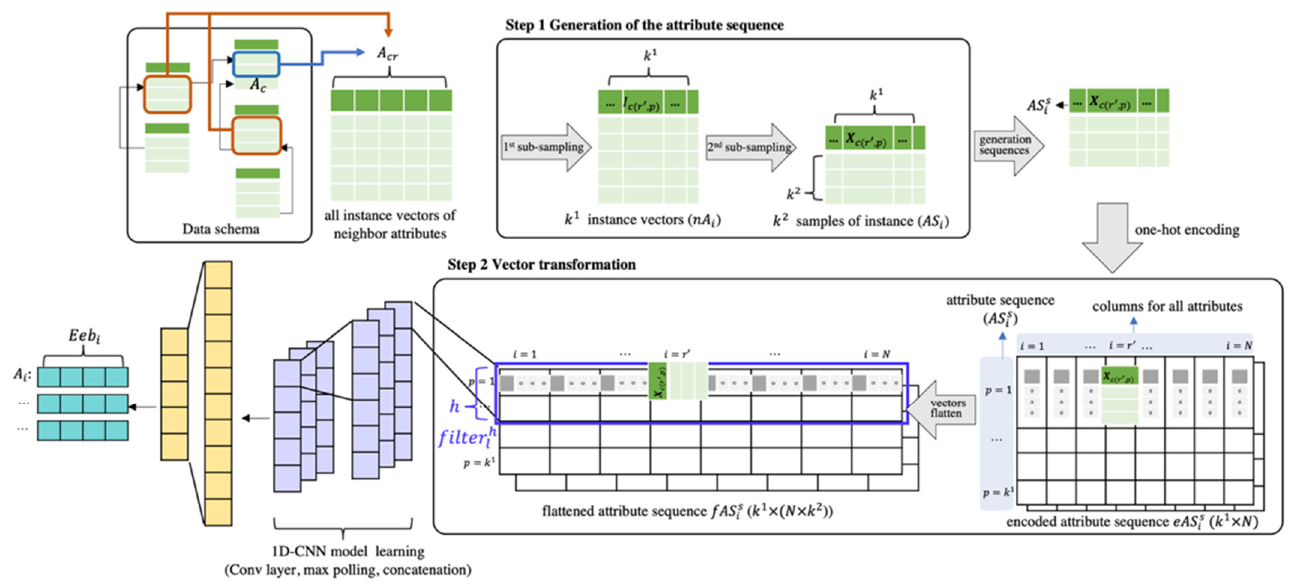
Figure 3. The proposed attribute representation learning with the 1D-CNN.